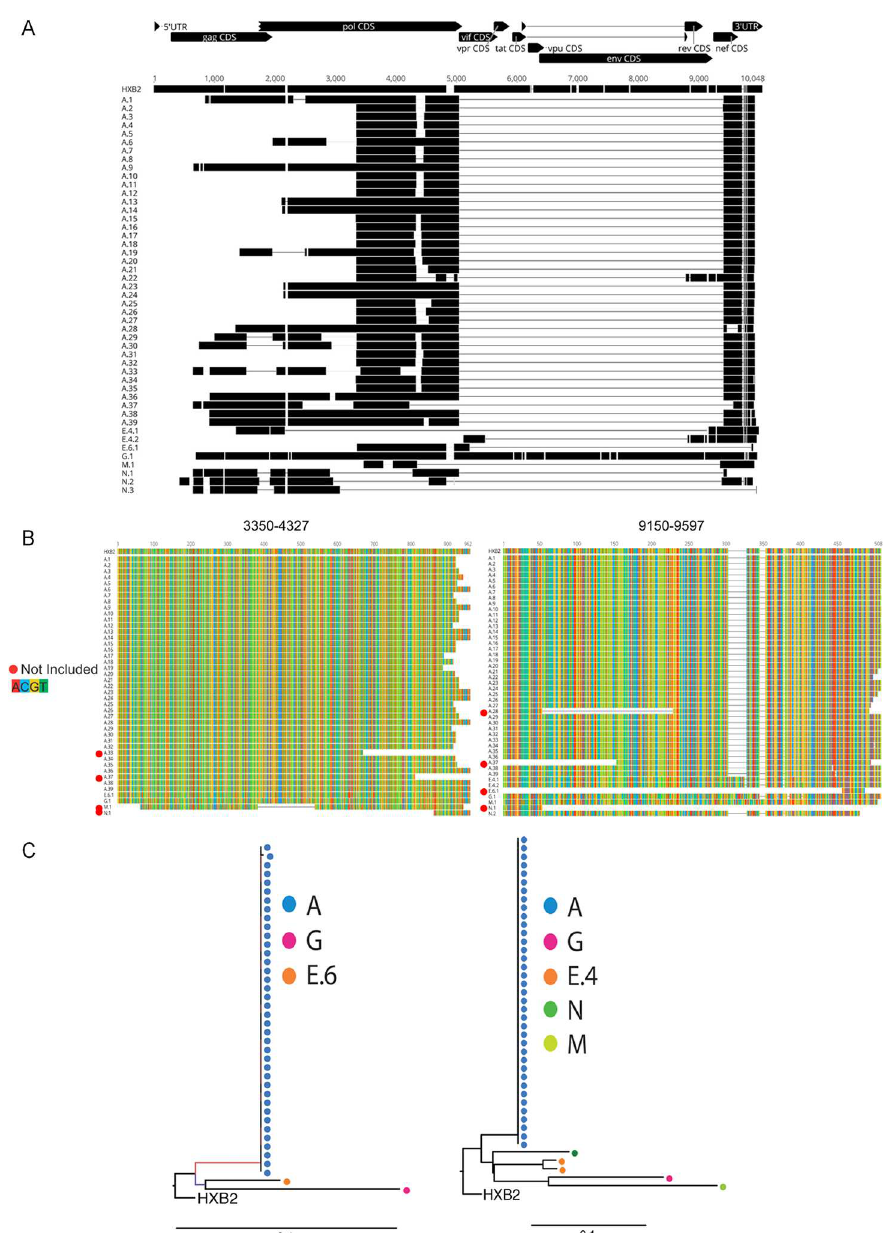
Fig 3. Deletions in NIPG with defined junctions. Letters and numberscorrespondto participantidentifiers listed in Table 1. A) Sequencesare alignedto HXB2. Sequenced positionsappearas a black polygon.Gray thin lines indicate deletedregionsof genomes.B) Regionswith relatively high coveragewere extracted for phylogenetic analysis. Locationshown is accordingto HXB2 numbering.Colors correspond to nucleotides on the left. Sequencesdesignatedwith a red dot were not used in subsequent analysisdue to missing sequence segments. C) Phylogenetic analysisof sequencesrooted using HXB2 and alignedto positions3350–4327 and